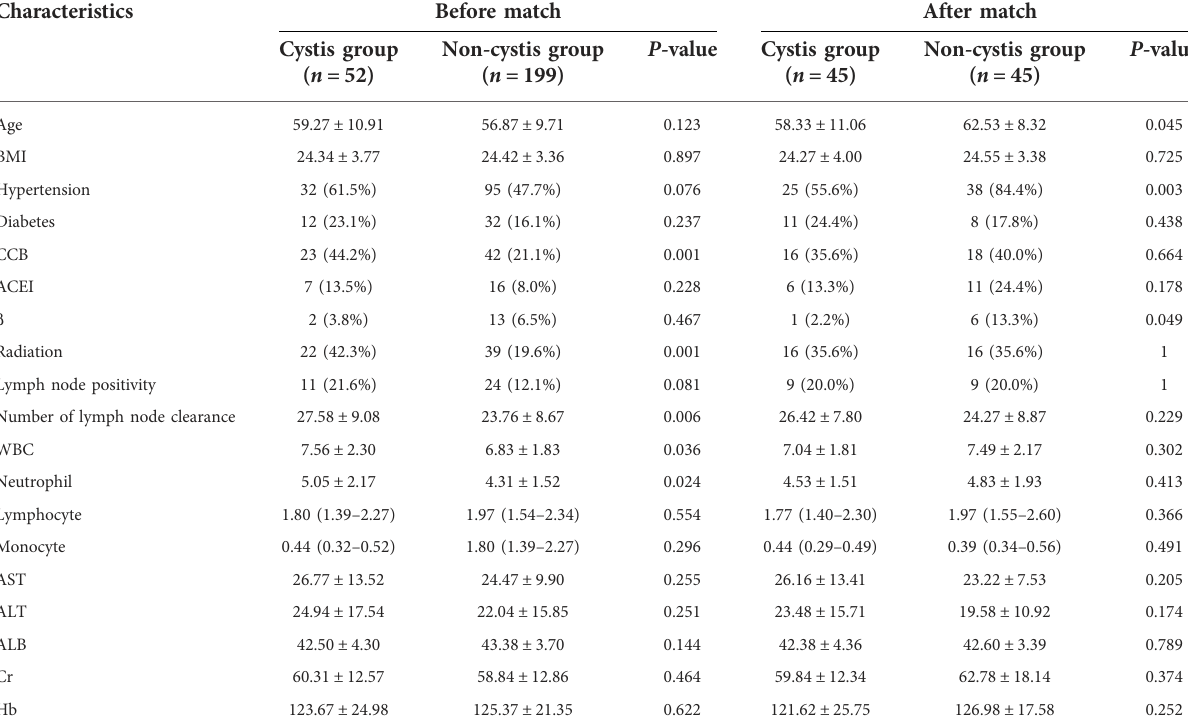
TABLE 6 Propensity score matching for